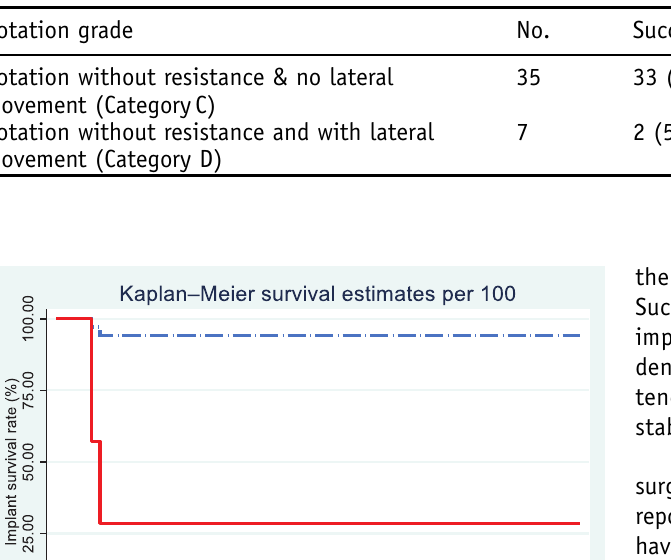
Table II. Success and failure for zero implant insertion torque with& without lateral movement.